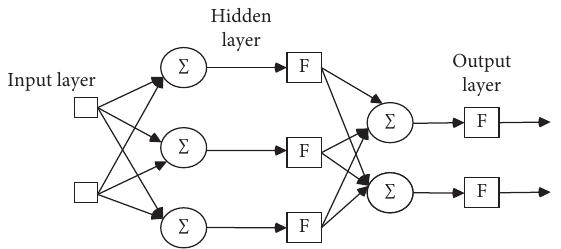
Figure 2: Diagram of a multilayer perceptron network.